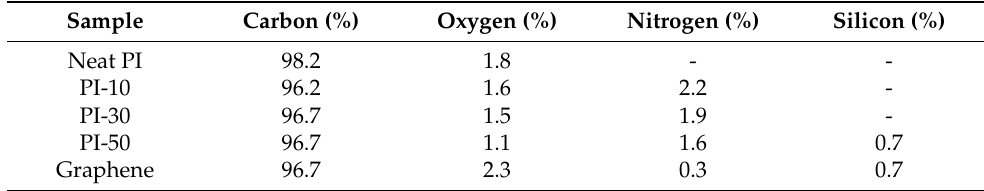
Table 2. SEM-EDX analysis of char from neat polyimide, grapheme, and composites containing 10, 30, and 50 wt.% graphene.